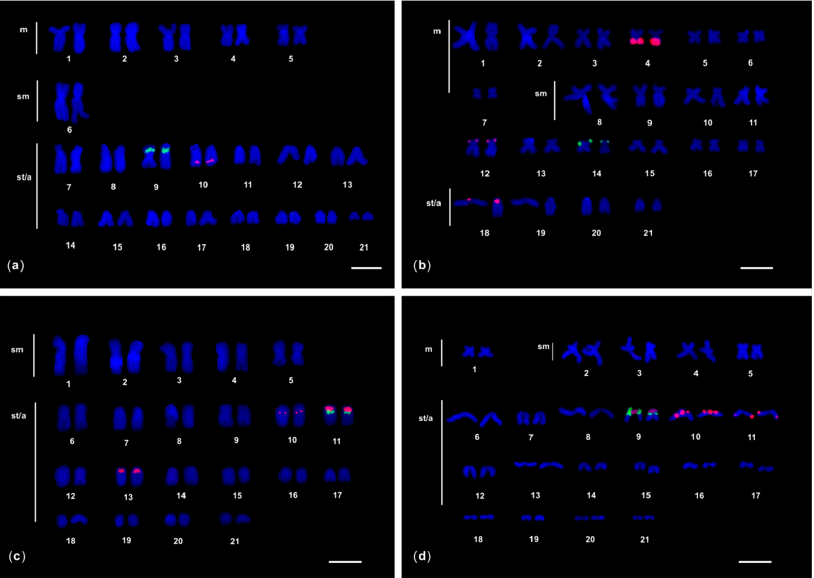
Figure 2. Karyotypes of ( a ) G. unicolor ; ( b ) G. tile; ( c ) G. undulatus; and ( d ) G. fimbriatus after 5S (red fluorescence) and 28S (green fluorescence) rDNA dual colour FISH. The chromosomes were counterstained with DAPI. m : metacentric chromosomes, sm : submetacentric chromosomes, st : subtelocentric chromosomes, a : acrocentric chromosomes. The bar represents 5 μ m.